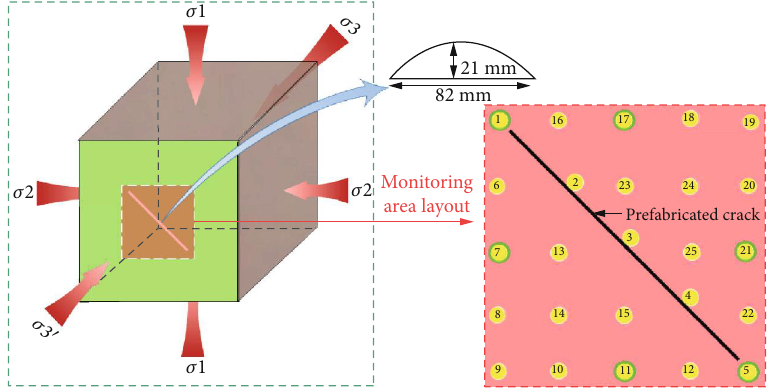
Figure 3: Layout of monitoring